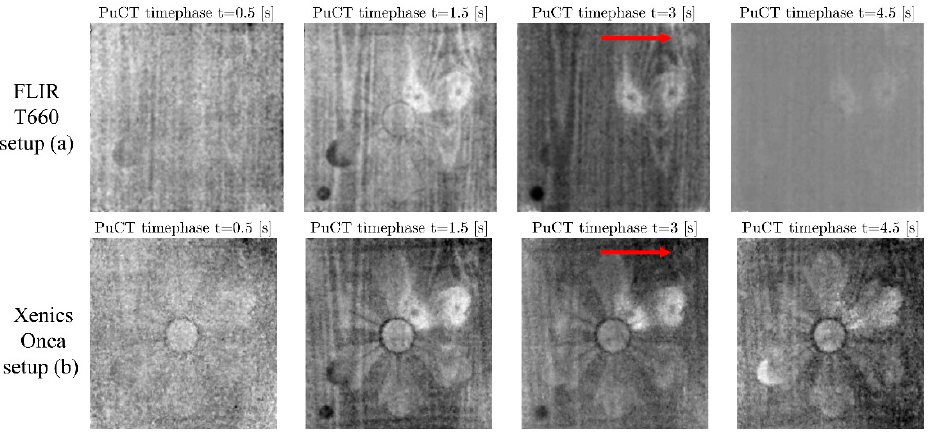
Figure 9. Selected thermograms imaging the timephase feature for PuCT data, from both setup ( a ) and setup ( b ).